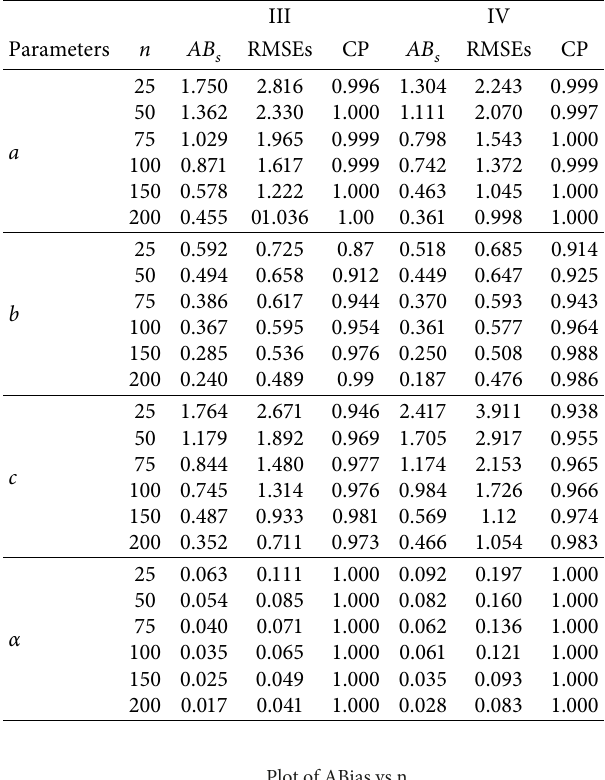
Table 4: The results of AB s , RMSEs, and CP for the MLEs of ExEW distribution for III and IV.